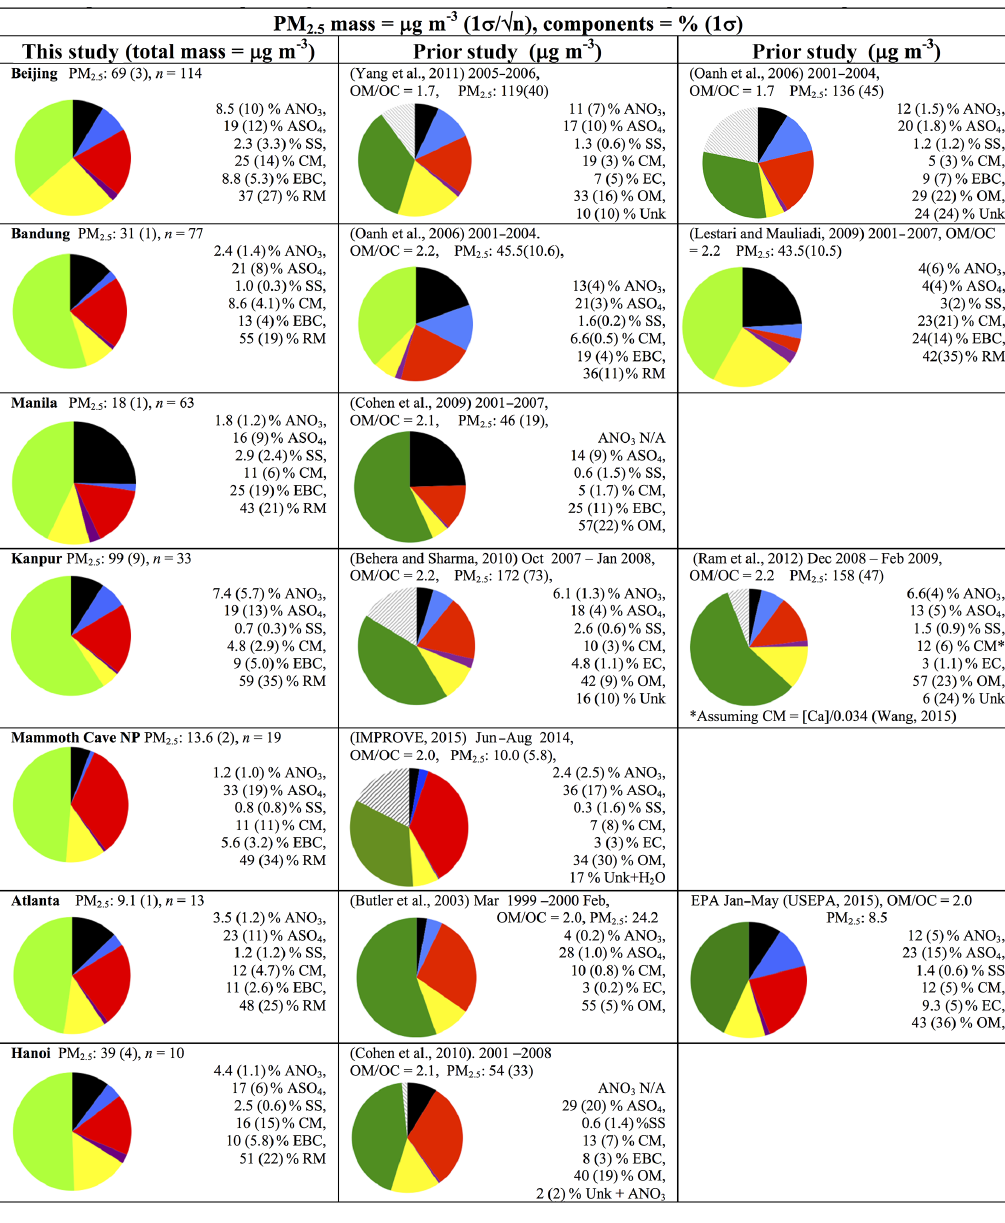
Figure 3. Comparison of SPARTAN water-free aerosol composition with 11 collocated speciation studies. The numbers in parentheses show 1 σ deviations of averaged masses. The number of filters sampled is n . Dark green indicates organic, light green indicates residual matter, black indicates equivalent black carbon, red indicates ammoniated sulfate, blue indicates ammonium nitrate, purple indicates sea salt, yellow indicates crustal, and grey stripes indicates what is unknown. OM:OC ratios are from Philip et al. (2014b) and Canagaratna et al. (2015). Relative mass percentages are based on water-free aerosol components. SPARTAN percentages are renormalized to 100% after omission of species not found in comparison